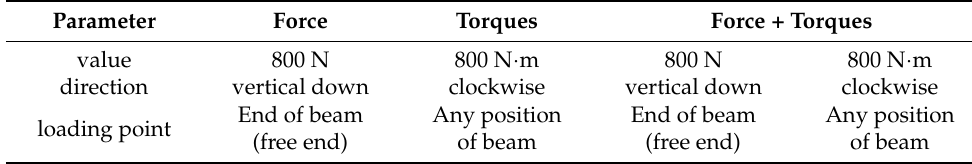
Table 4. Parameters of the applied load.